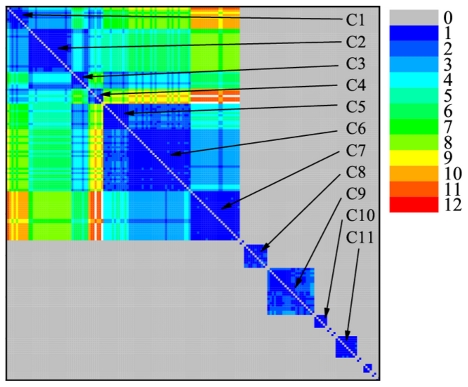
The neighborhood matrix with the 11 modules for Acetyl at
σ = σmax = 42%.